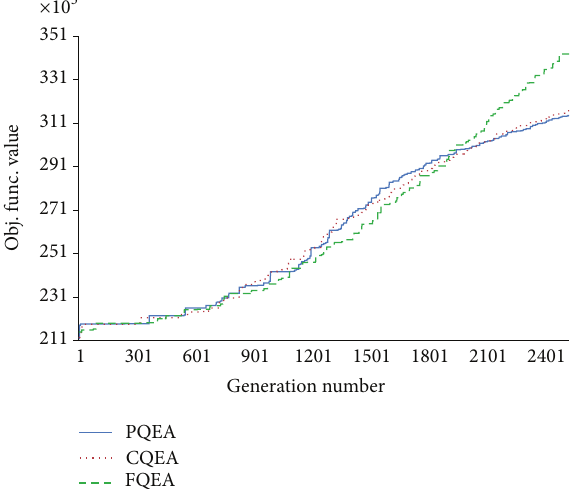
Figure 35: Convergence graph of PQEA, CQEA, and FQEA on 0-1 knapsack problem with circle data instances with number of items, 𝑀 , being 200 and capacity, 𝐶 , being 10% of total weight.